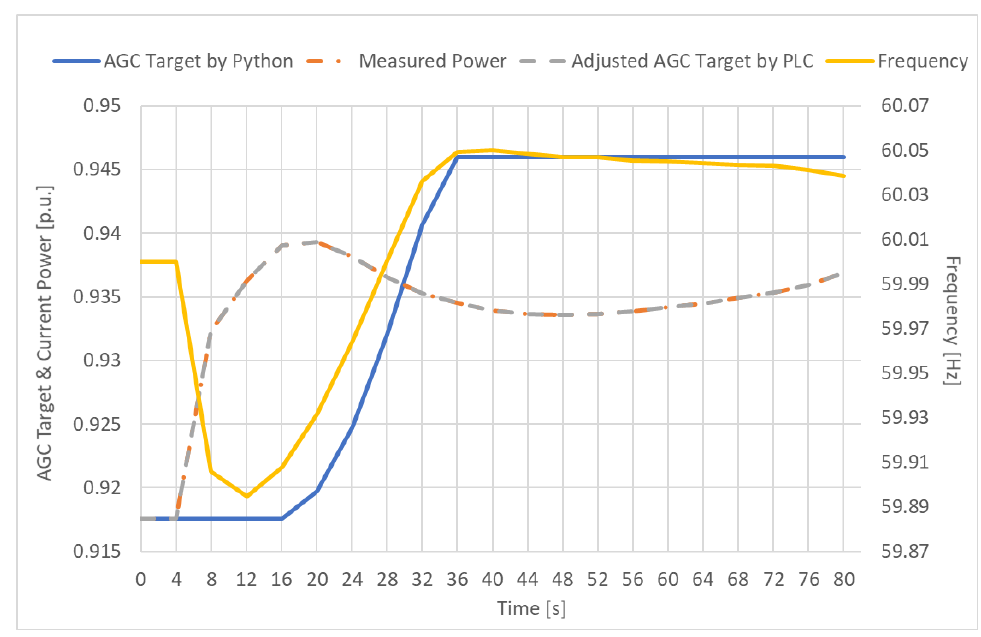
Figure 14. Revised AGC target by the plant-level controller function.